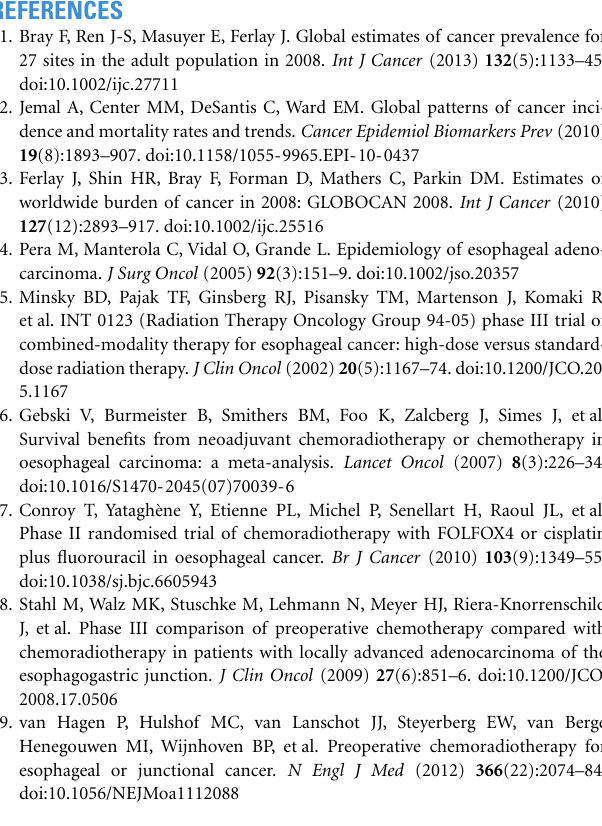
Figure S1 | Overall survival curve using Kaplan–Meier methods for elderly patients treated for esophageal and gastroesophageal cancer, with age < 78years (blue line) or > 78years (green line) . Figure S2 | Overall survival curve using Kaplan Meier methods for elderly patients treated for esophageal and gastroesophageal cancer according performance status (PS) . Table S1 | Pathological findings after oesophagectomy